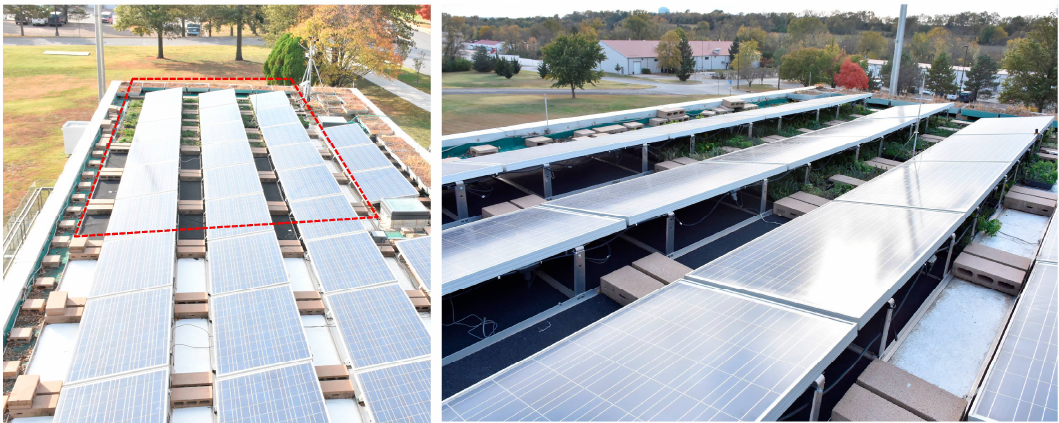
Figure 2. Experimental bed configurations. Table 2. Enphase microinverter specifications.